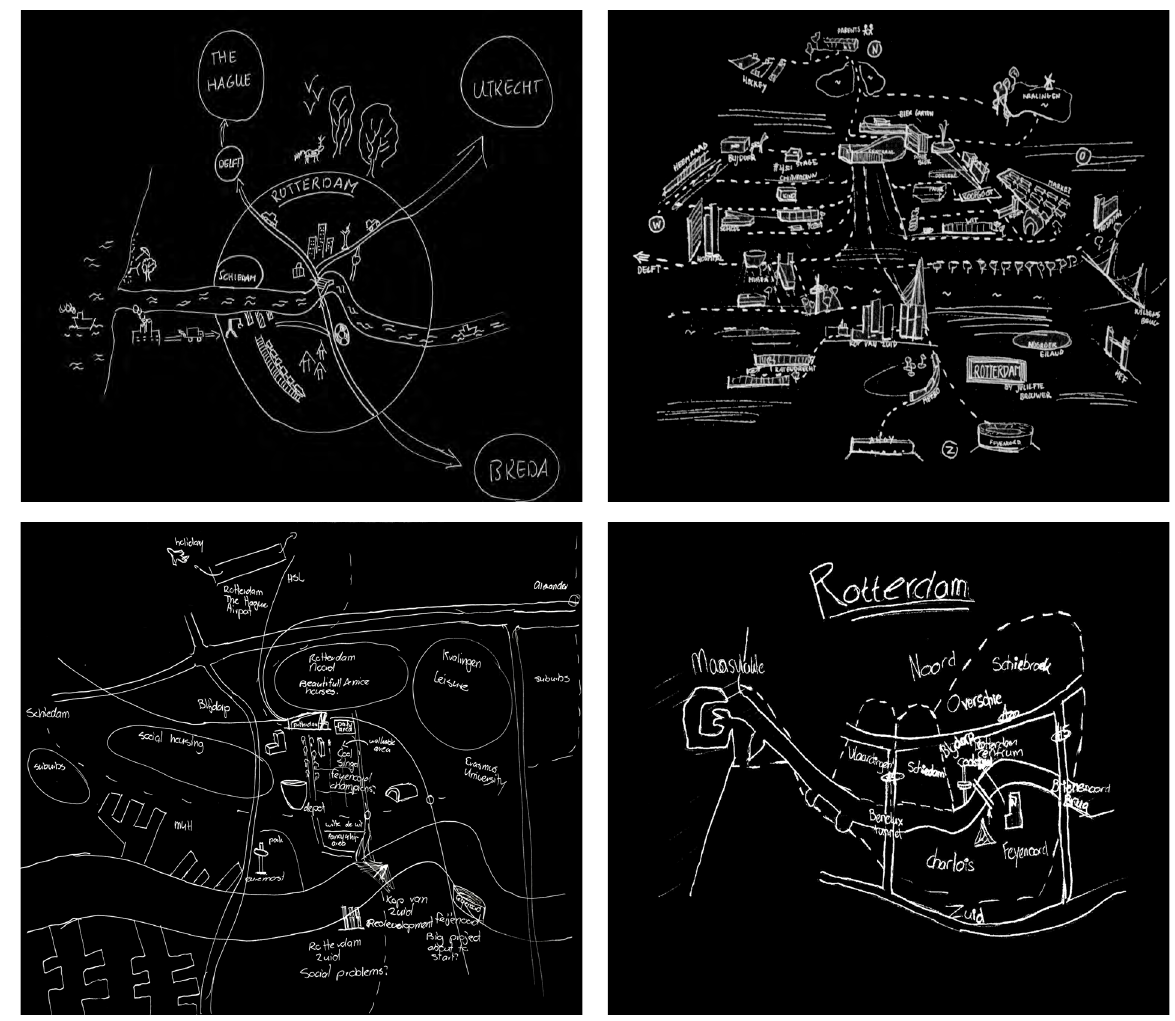
FIG. 4 Mental Maps of Rotterdam, examples drawn by students of Transport, Infrastructure and Logistics (a), Urbanism (b), Architecture (c) and Complex Systems Engineering and Management (d), 2020, credits trough anonymized responses in the graduate course on People, Movement and Public Space by Maurice